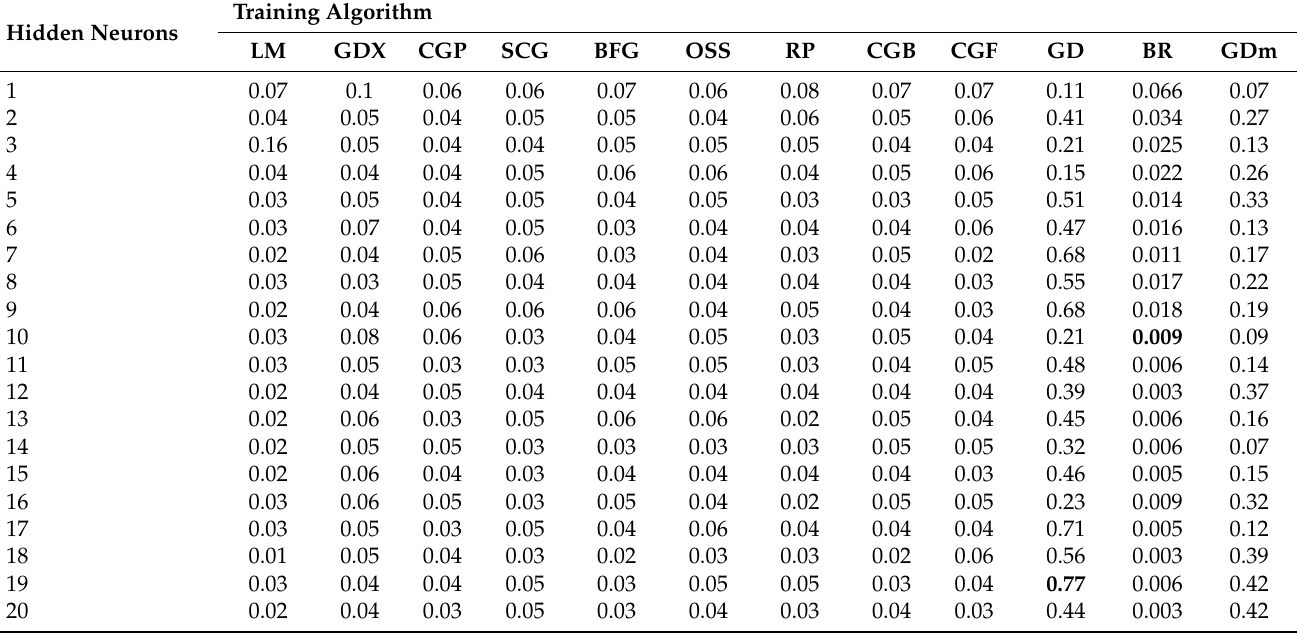
Table A9. MAPE for COD removal (%) for different training algorithms at different number of hidden neurons.